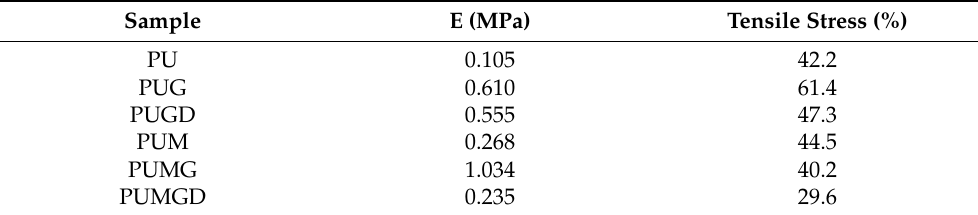
Table 6. Mechanical properties for the polyurea based nanocomposites. Sample E